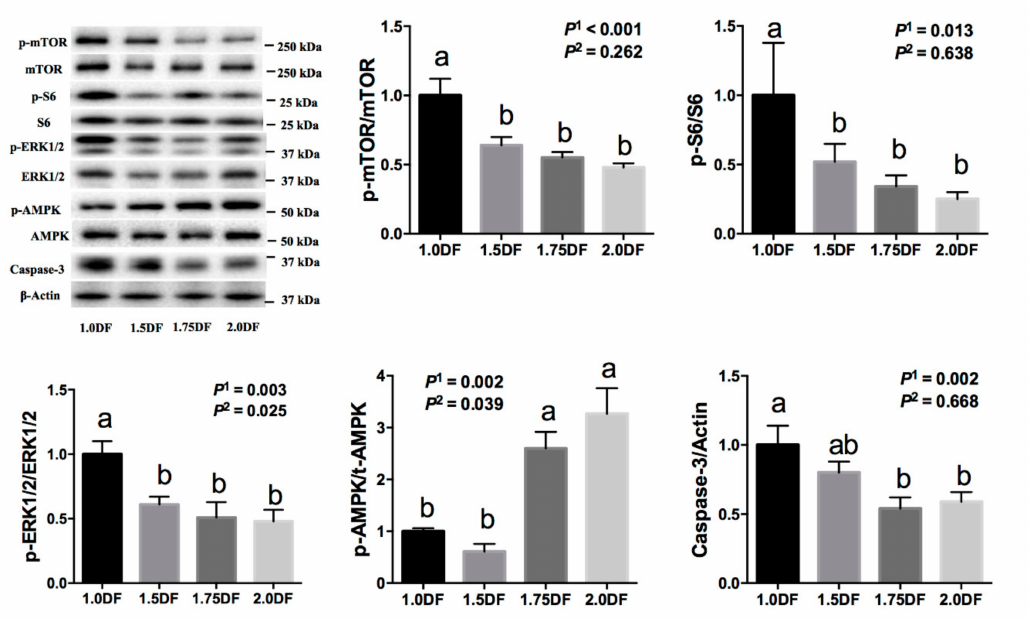
Figure 2. E ff ects of dietary fiber intake levels on the protein expressions of ovarian tissues in gilts on day 30 of the experiment. Data are expressed as means ± SE; n = 6; DF, dietary fiber; P 1 denotes linear e ff ects; P 2 denotes quadratic e ff ects; a,b denotes p <